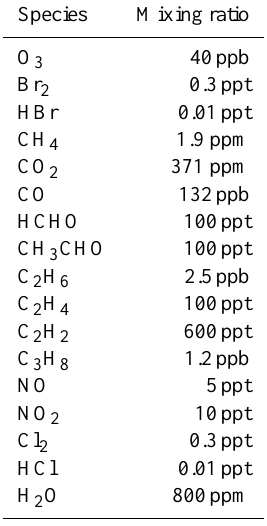
Table 2. Initial gas composition (ppm is parts per million, ppb is parts per billion, ppt is parts per